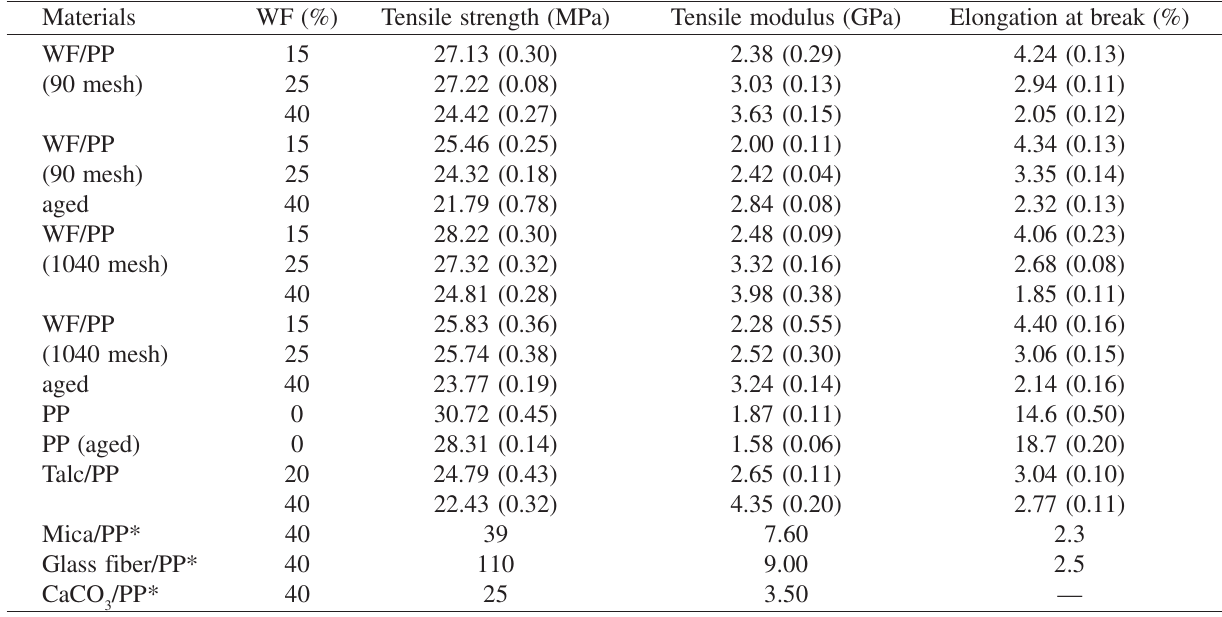
Table 1. Tensile mechanical properties of WF/PP composites with or without accelerated aging (comparison with data on commercially available polypropylene and composites); the values in parenthesis correspond to standard deviations of the measurements.